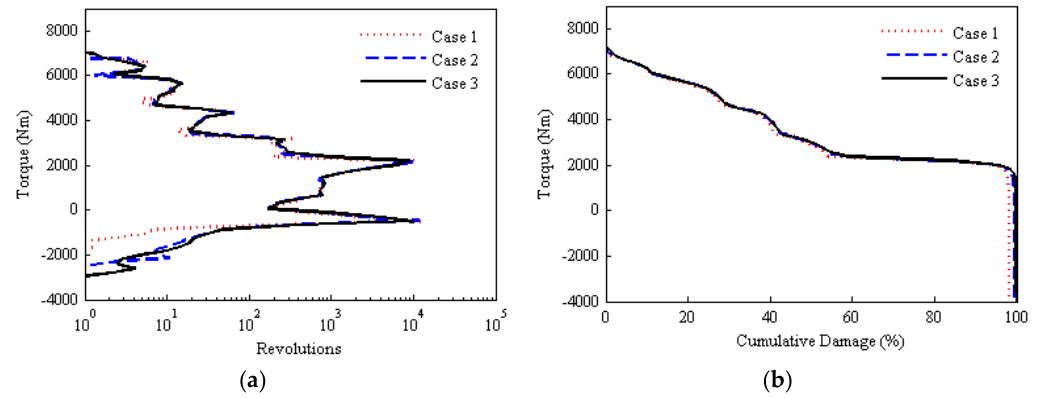
Figure 13. Rotating moment histogram (RMH) analysis of the engine output shaft toque: ( a ) torque vs. revolutions ( b ) torque vs. cumulative damage (%).